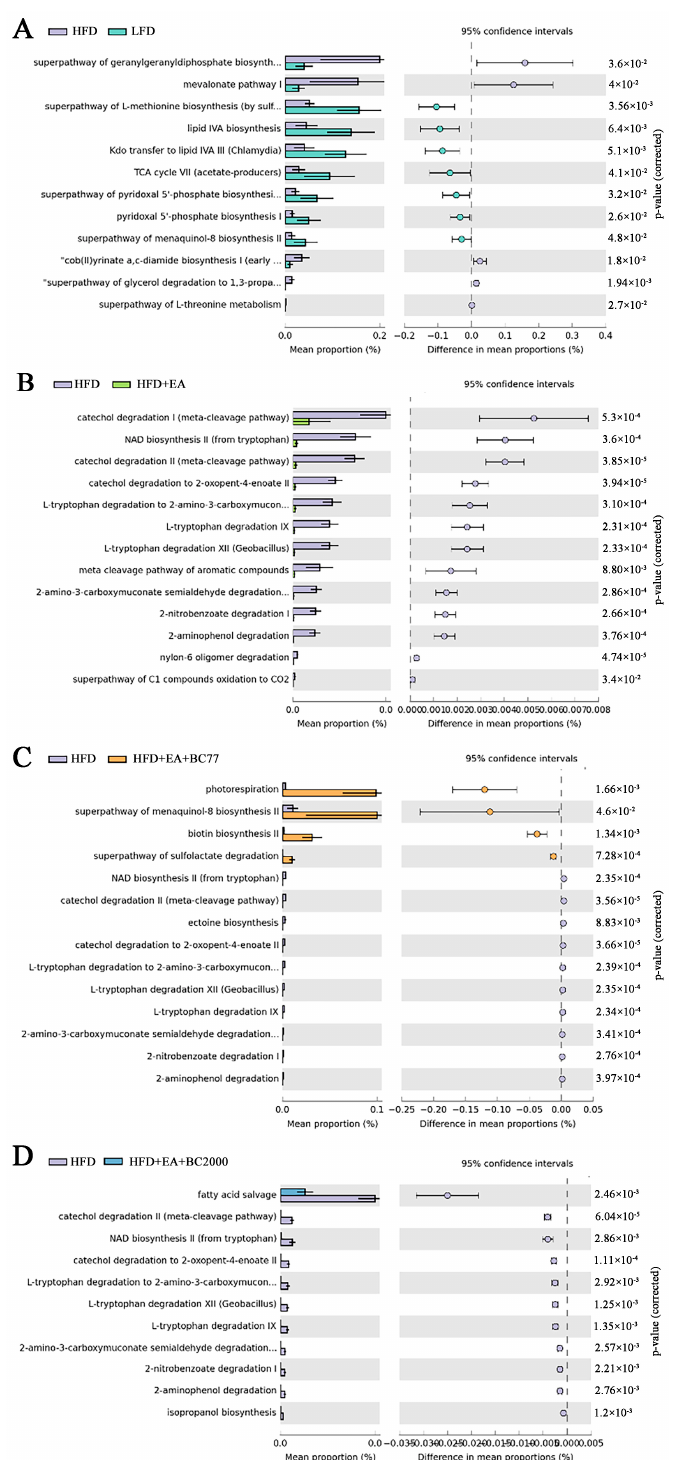
Figure 5. Significant differences (FDR-adjusted p -value < 0.05) between groups in MetaCyc Gene Pathways predicted by PICRUSt2. ( A ) HFD VS LFD; ( B ) HFD VS HFD + EA; ( C ) HFD VS HFD + EA + BC77; ( D ) HFD VS HFD + EA + BC2000. n = 6/group. Data are expressed with log2FC. Differential expression is analyzed using the edgeR software. LFD: low-fat-diet group; HFD: high-fat-diet group; HFD + EA: high-fat-diet supplemented with ellagic acid; HFD + EA + BC77: high-fat-diet supplemented with ellagic acid and W. coagulans BC77; HFD + EA + BC2000: high-fat-diet supplemented with ellagic acid and W. coagulans BC2000.